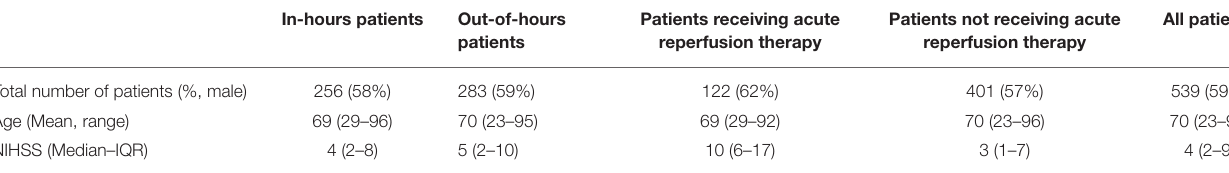
TABLE 1 | Patient population characteristics in-hours vs. out-of hours and treated vs. non-treated with acute reperfusion therapy.